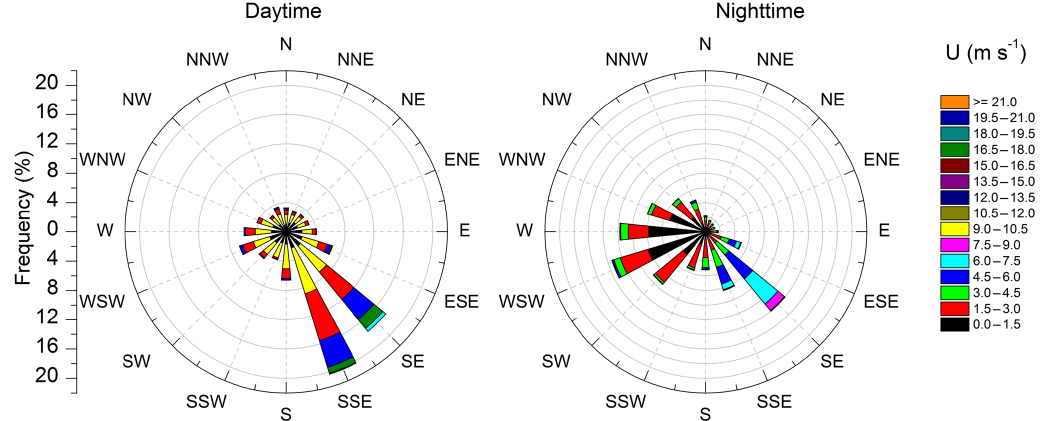
Figure 2. The wind rose of Erhai Lake during daytime (when downward shortwave radiation is greater than 20Wm − 2 ) and nighttime (when downward shortwave radiation is less than 20Wm − 2 ) from 2012 to